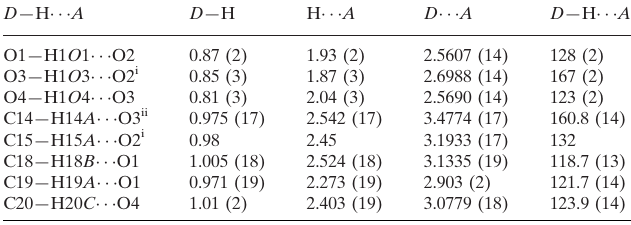
Hydrogen-bond geometry (A˚ , (cid:4)